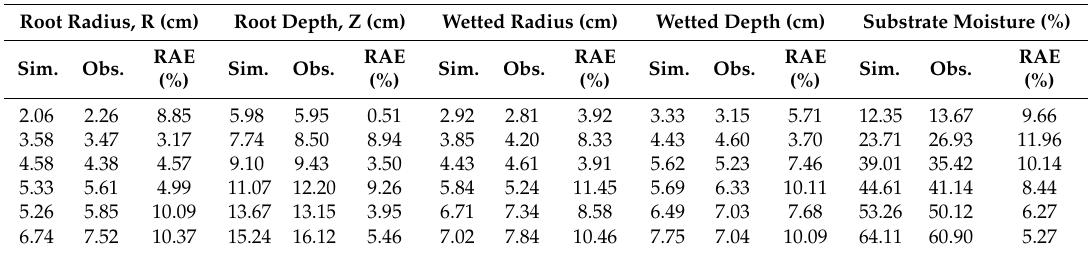
Table 3. Results of model calibration using experiment data obtained from lettuce cultivated in a substrate under drip irrigation. Root Radius, R (cm) Sim.